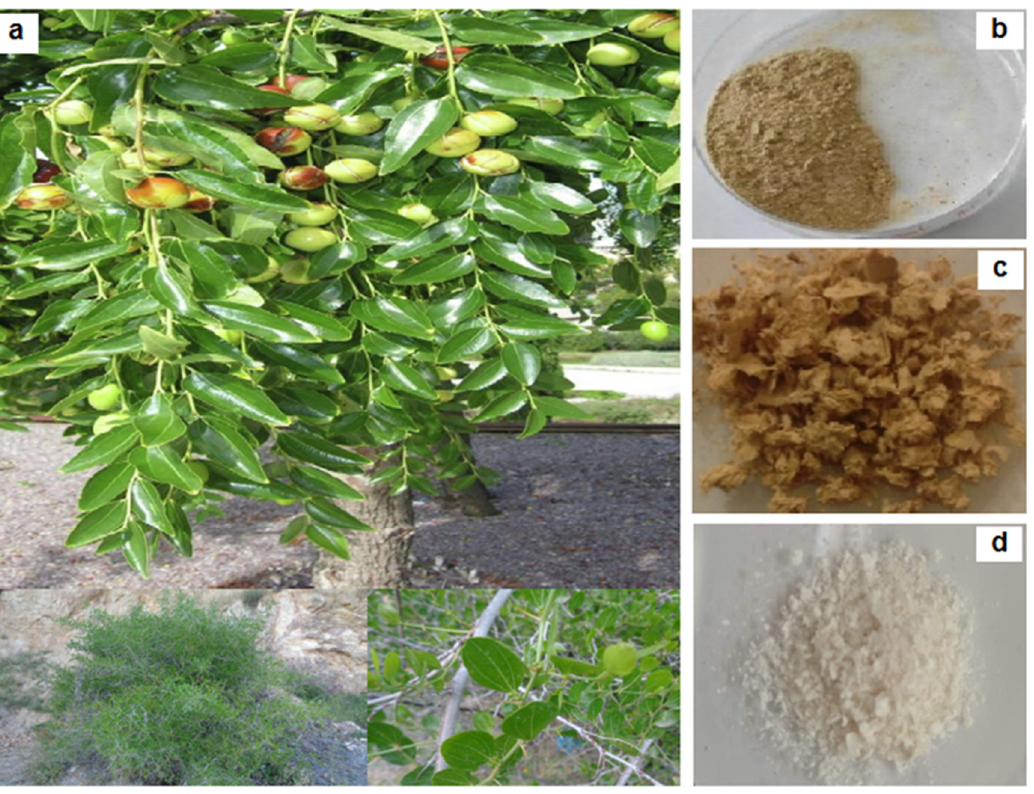
Figure 1. Photographs of ( a ) Ziziphus jujuba plant, ( b ) untreated Ziziphus jujuba material, ( c ) alkali- treated samples and ( d ) final bleached cellulose.